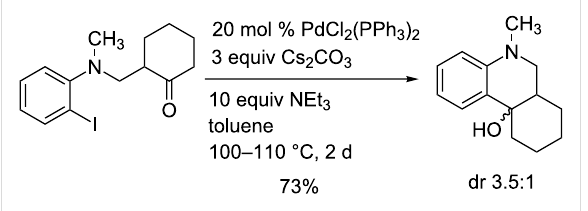
flected in the product structure. Compound 5b provided prod- uct 15b with trans -annulation of the two rings and we assume that compound 15a with cis -annulated rings was formed selec- tively from precursor 5a